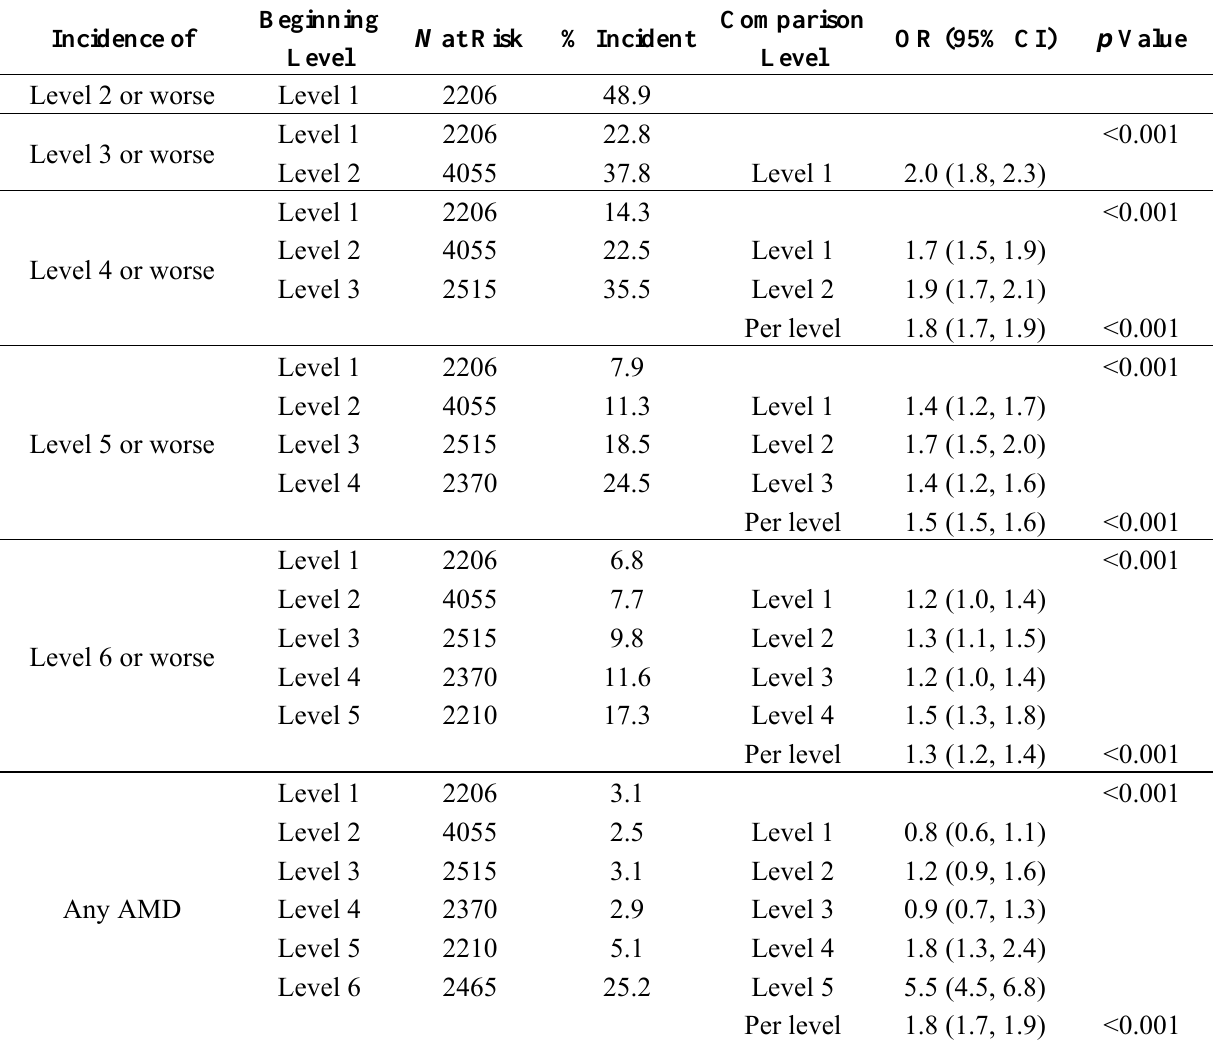
Table 2. Incidence of specific level of drusen area/severity by initial severity level. N is the number of person-visit-eyes at risk. The p value is the Wald test for any differences between levels. AMD, age-related macular degeneration; CI, confidence interval; OR, odds